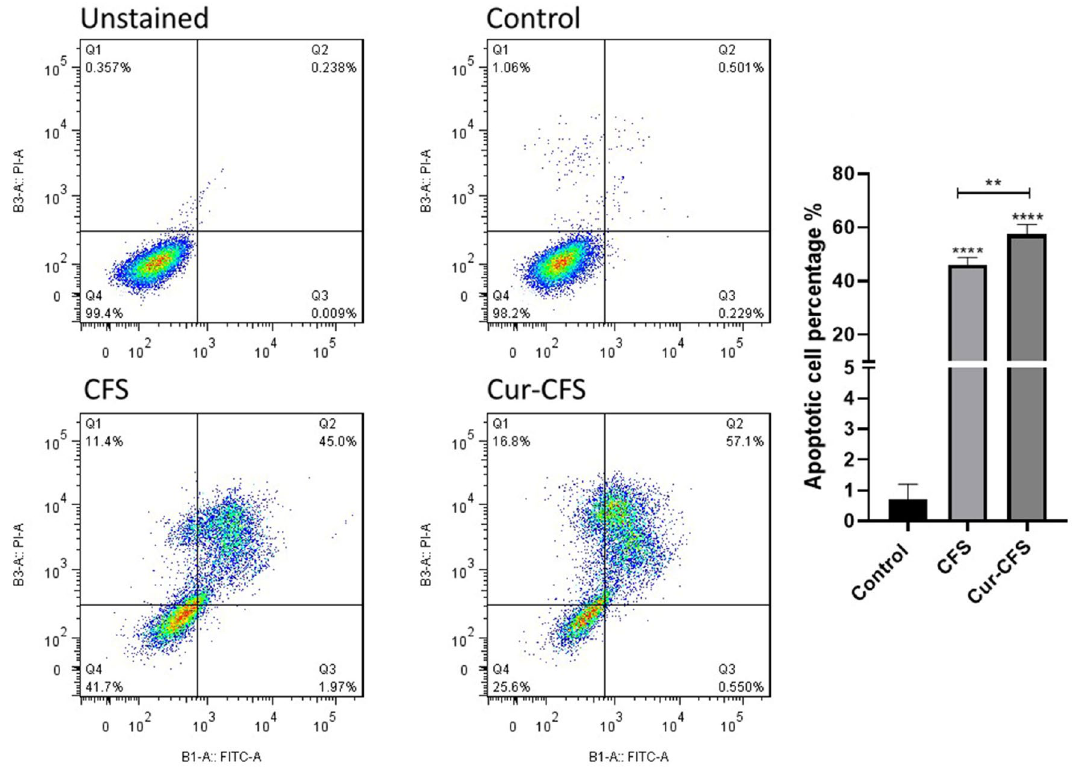
Figure 4. Flow cytometry quantification of apoptosis and necrosis in HT-29 colon cancer cells treated with CFS and cur-CFS in comparison with unstained and positive